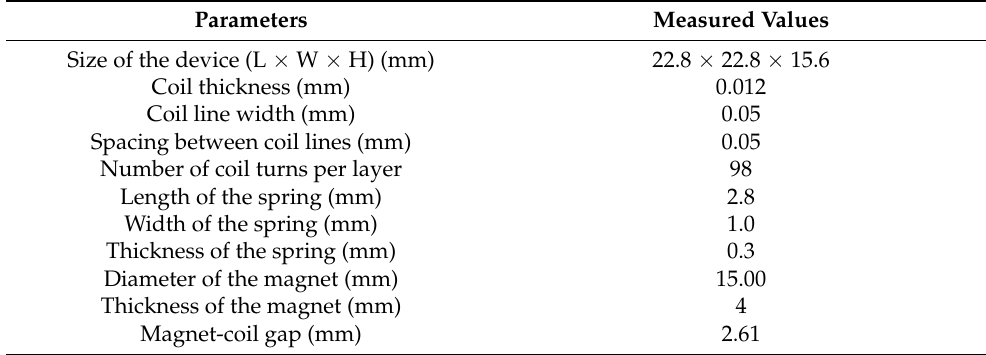
Figure 4. Photos of the ( a ) fabricated EVEH device, ( b ) side view of the EVEH device, ( c ) flexible polymer coils and FR4 boards, ( d ) assembled flexible coil stack, and ( e ) magnets and spring. Table 2. Measured geometrical parameters of the fabricated